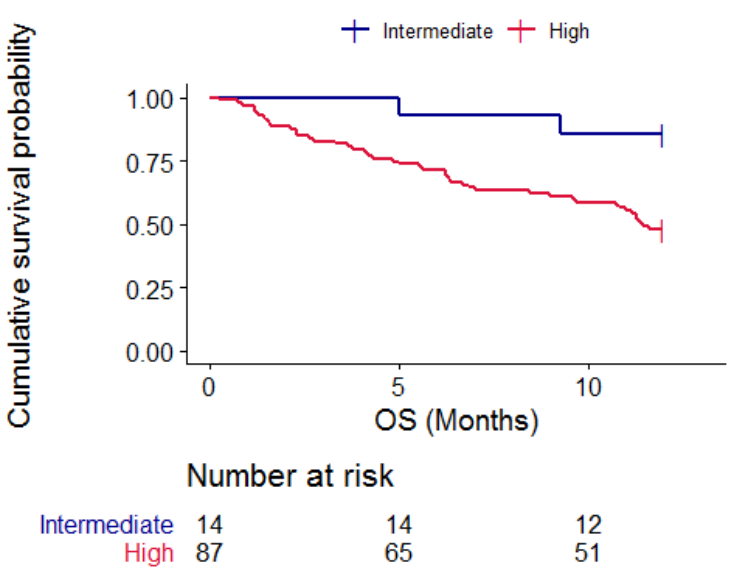
Figure 4. Kaplan–Meier curves representing one-year OS according to onco-MPI categories, blue = intermediate risk patients and red = high-risk patients. p =